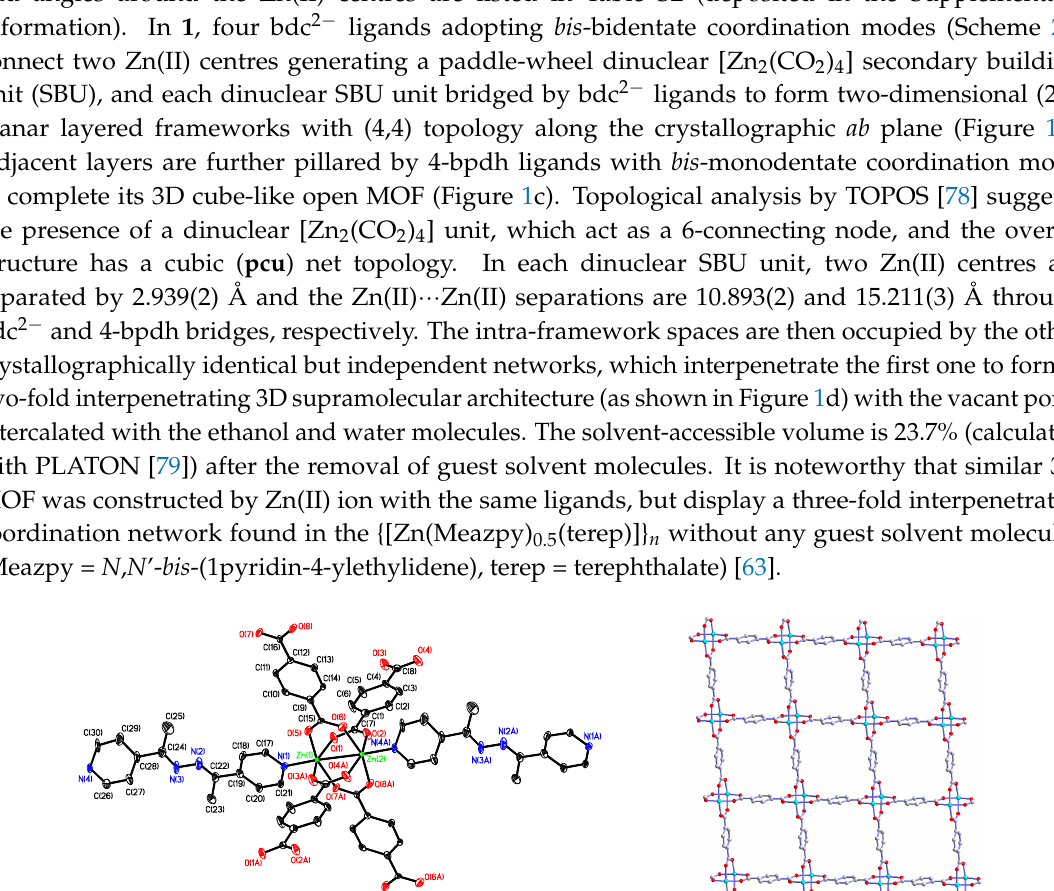
Figure 1. ( a ) Square-pyramidal coordination environments about Zn(II) ion in 1 with atom labelling scheme (Oak Ridge Thermal Ellipsoid Plot (ORTEP) drawing, 30% thermal ellipsoids). The solvent molecules and H atoms are omitted for clarity; ( b ) The two-dimensional (2D) layered framework